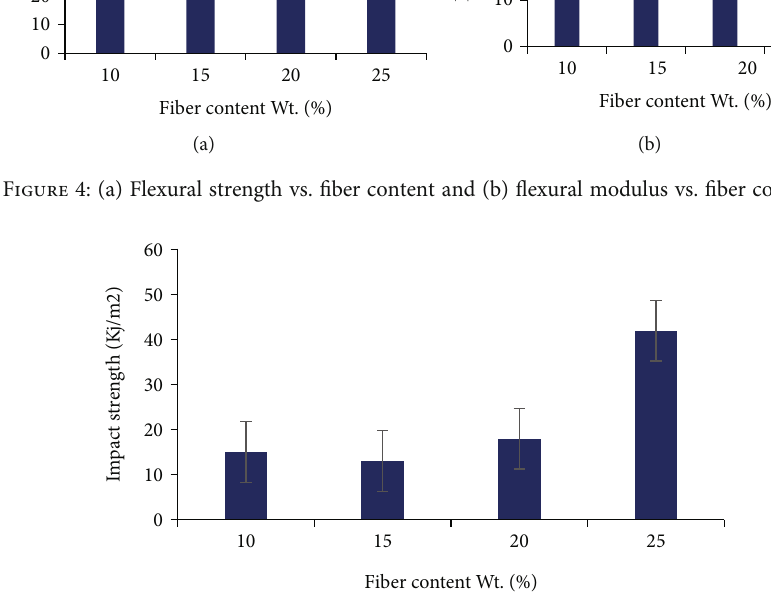
Figure 5: Impact strength vs. fi ber content.